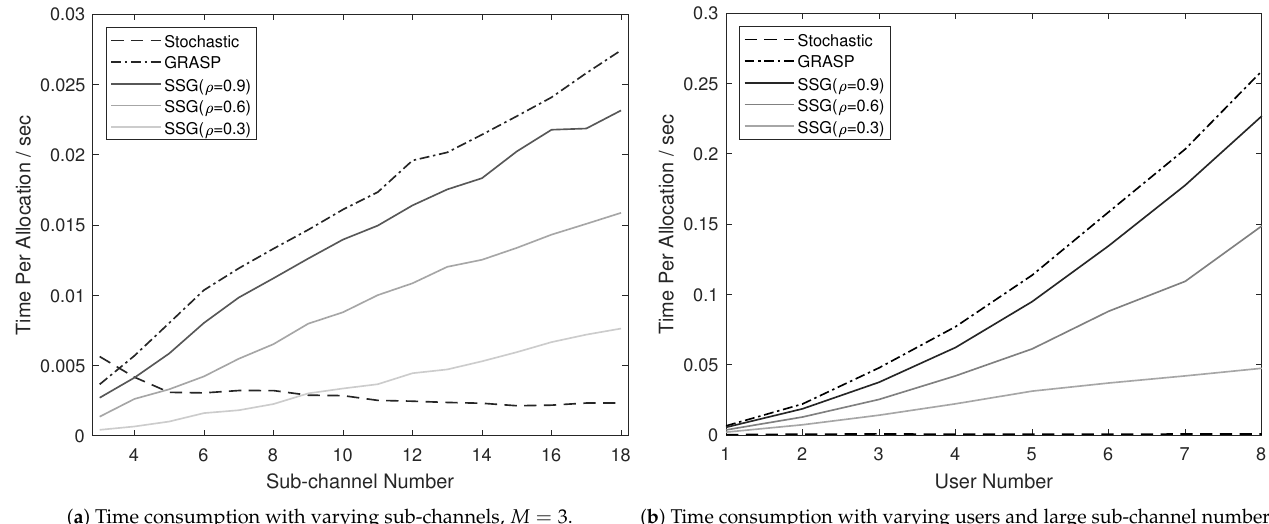
Figure 3. Analysis of actual running